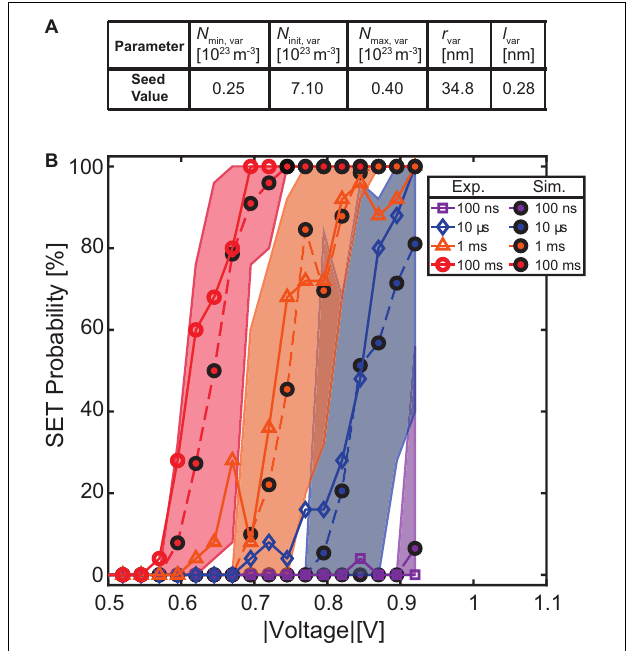
FIGURE 5 | (A) Shows the seed parameters of the simulated device. (B) Shows the SET probability as a function of the pulse amplitude for different pulse widths. An experimental and a simulation device, which are both close to the median on the 1 µ s timescale, are compared. Both voltage window and voltage onset in dependence of pulse duration are correctly described, verifying the predictive character of the compact model. The envelope areas quantify the maximum possible voltage shifts resulting from insufficient repetitions at a given